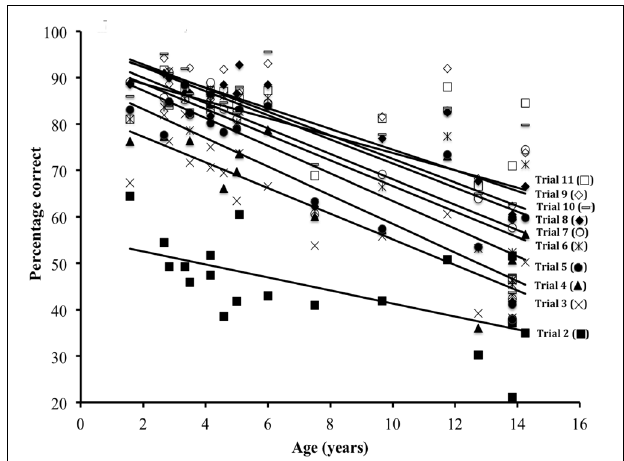
FIGURE 2 | Percentage correct as a function of the Age of participants and post-reversal trial number (from 2 to 11).